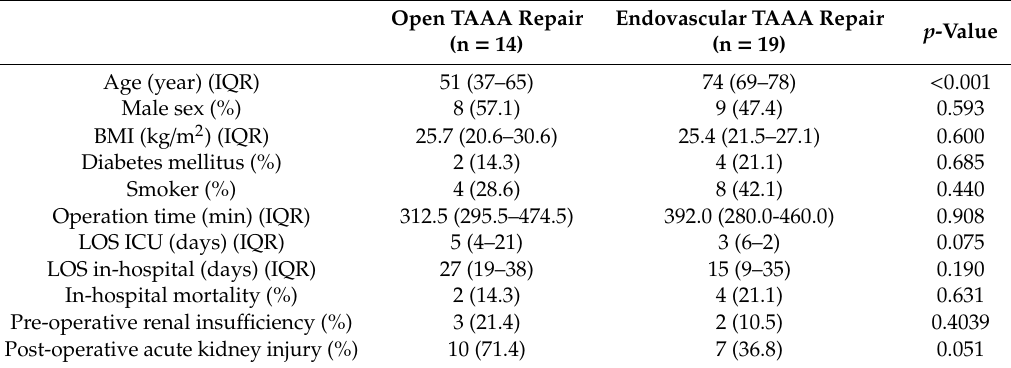
Table 1. Patient